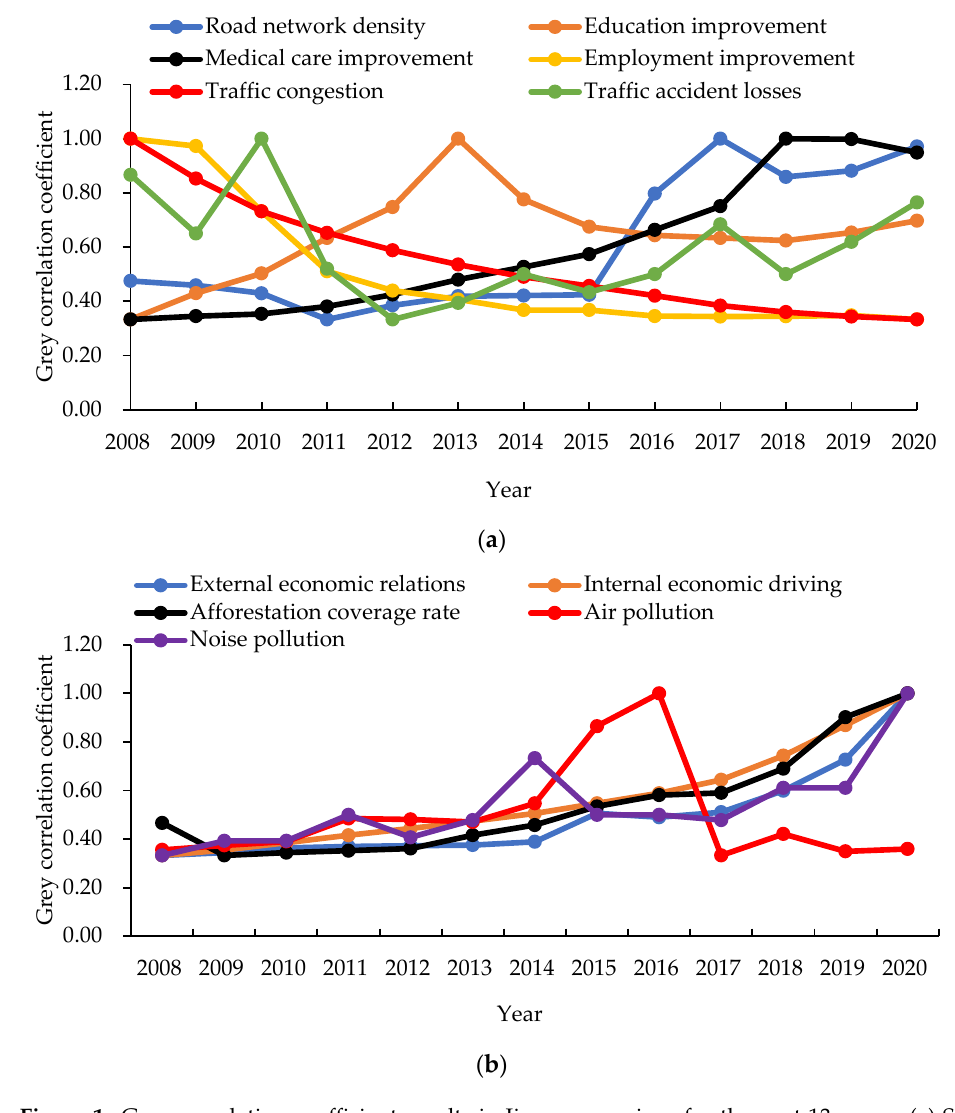
Figure 1. Grey correlation coefficient results in Jiangsu province for the past 13 years. ( a ) Social dimension; ( b ) economic and ecological dimensions.